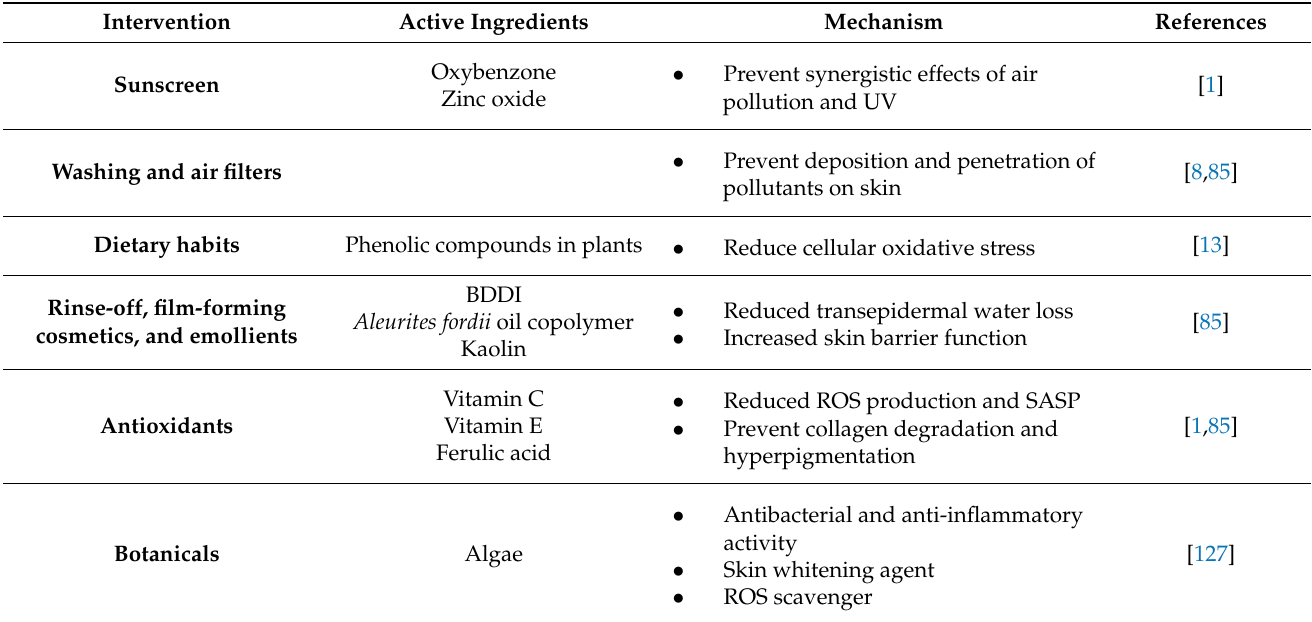
Table 1. A summary of the current interventions, an example of active ingredients, and which mechanisms are helping against air pollution-induced damage with corresponding references for detailed